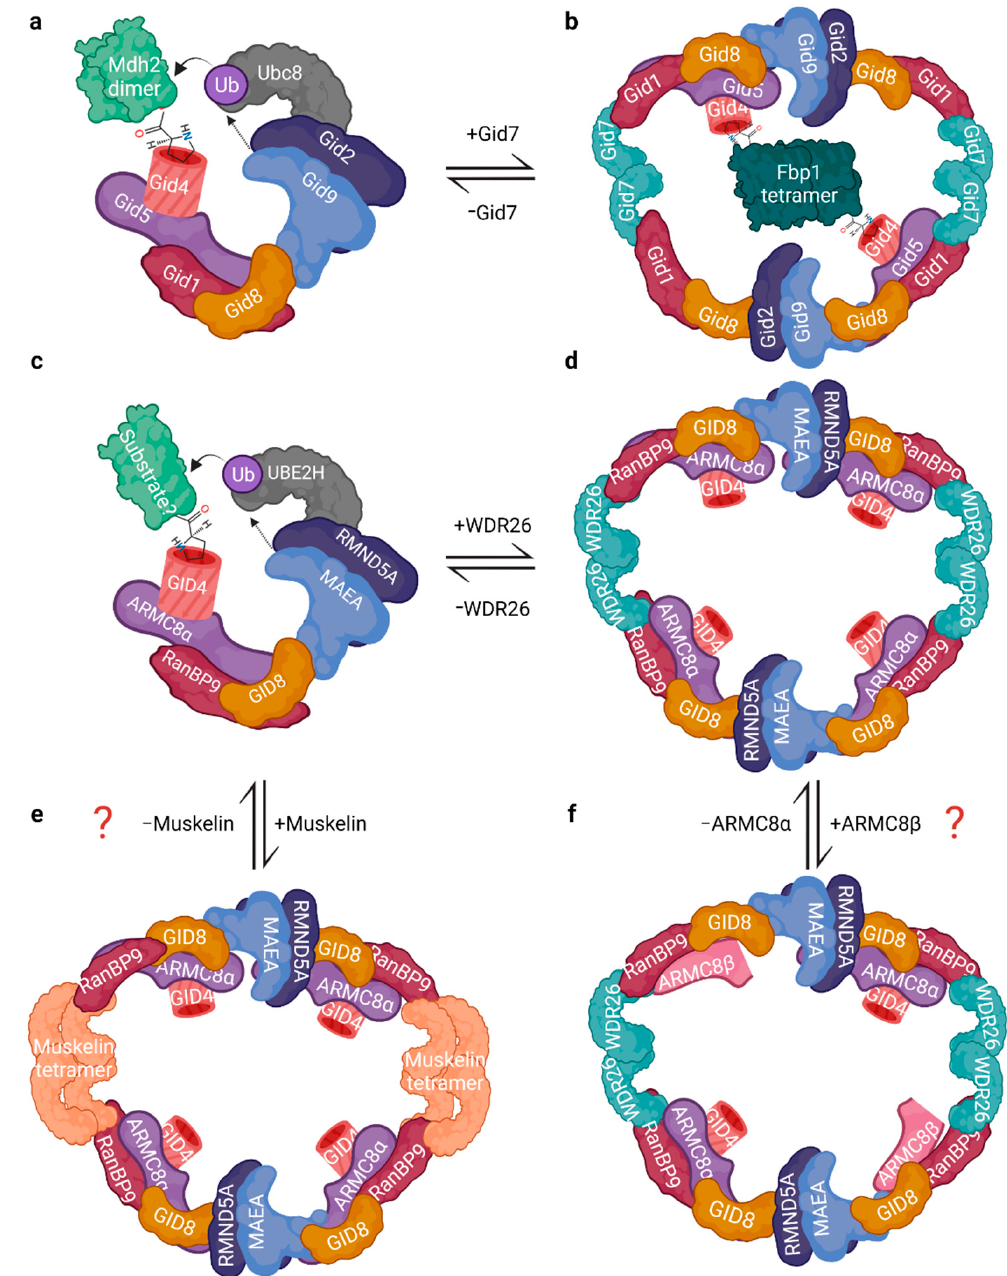
Figure 3. Architecture and assemblies of GID/CTLH complexes. ( a ) Schematic representation of the architecture of the monomeric S. cerevisiae Gid complex (without Gid7) binding its cognate E2 Ubc8 and dimeric substrate Mdh2 via N-terminal proline binding the Gid4 β -barrel. ( b ) Supramolecular chelator S. cerevisiae GID complex (with Gid7) that encircles its tetrameric substrate Fbp1. ( c ) Architecture of monomeric human CTLH complex (without WDR26 or muskelin) and its cognate E2 UBE2H binding a substrate via GID4. ( d ) Oligomeric assembly of the human CTLH complex containing WDR26. ( e , f ) Examples of possible CTLH supramolecular complexes. Additional assemblies may also be formed with RanBP10 and RMND5B paralogues, and different combinations of WDR26, muskelin, and ARMC8 isoforms. For structural details, see text and Qiao et al., 2019, and Sherpa et al., 2021. Created with Biorender.com (21 April 2022).